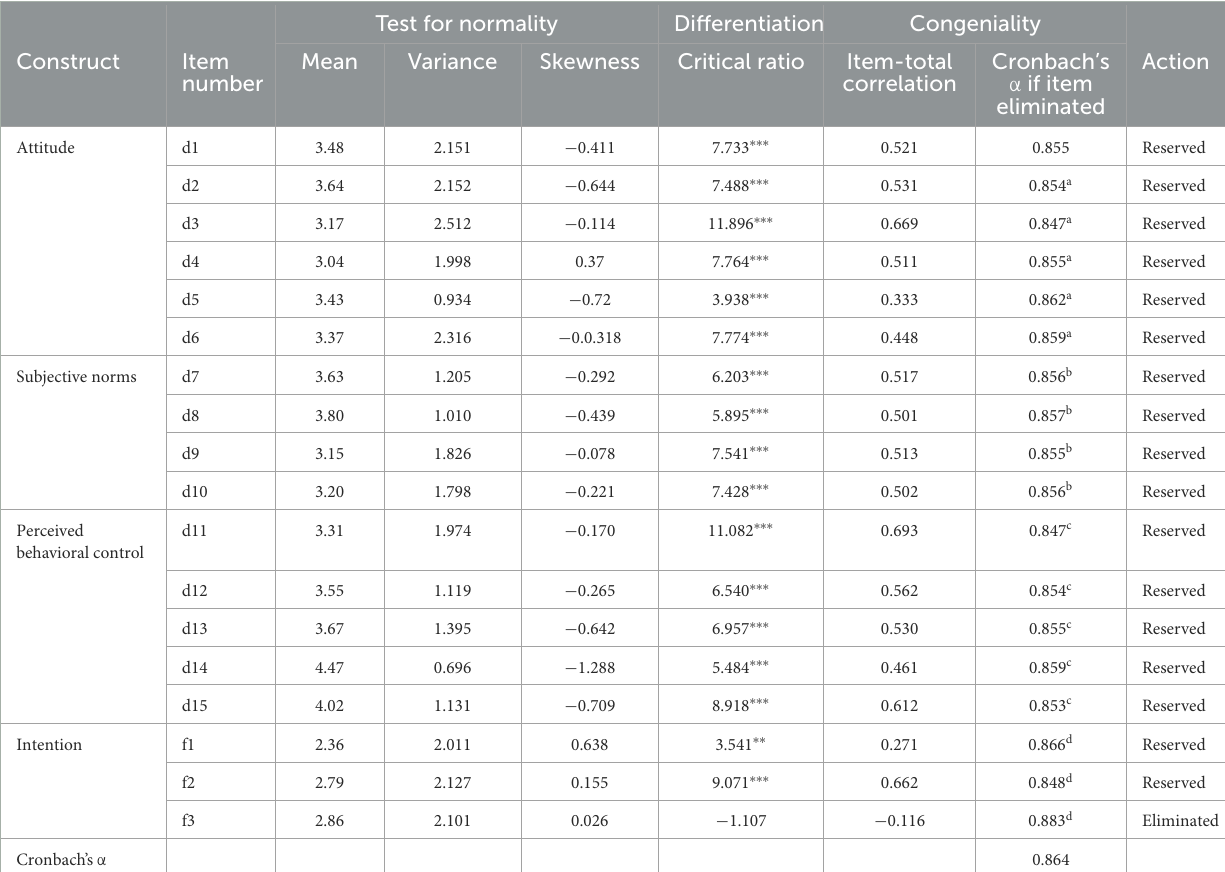
TABLE 2 Item analysis for the investigated items of scale based on the theory of planned behavior. Test for normality Differentiation Congeniality Construct Item Mean Variance Skewness Critical ratio Item-total number